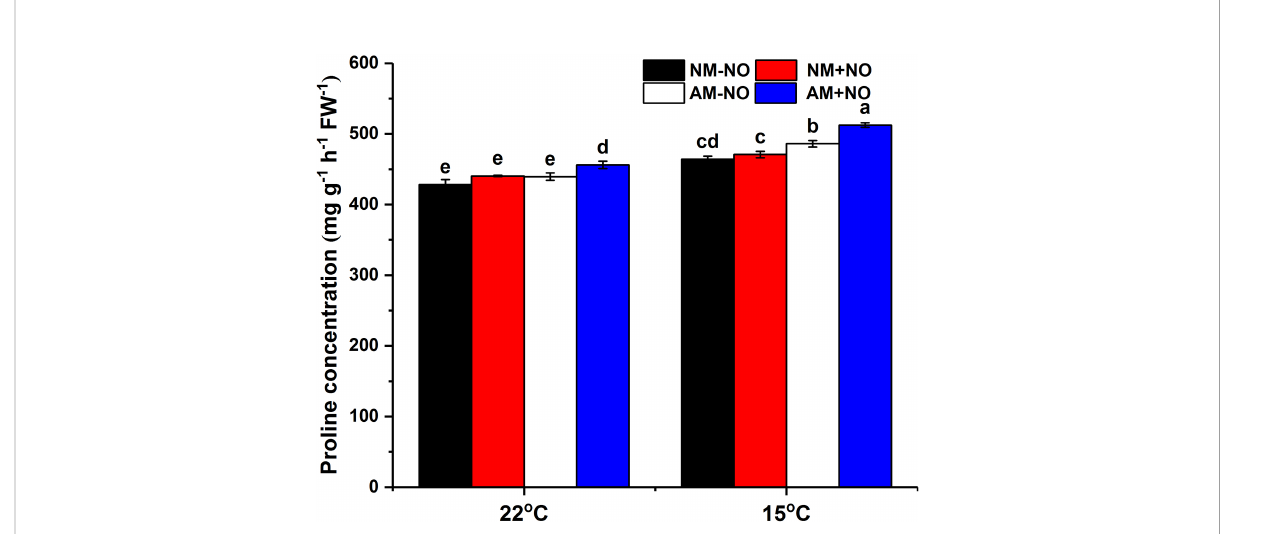
FIGURE 1 Proline concentration of non-mycorrhizal and mycorrhizal rice treated with different temperatures (25°C and 15°C) and exogenous NO. NM- NO: non-mycorrhizal rice without NO donor, SNP, treatment ( black bars ); NM+NO: NO donor treatment for non-mycorrhizal rice ( red bars ); AM-NO: mycorrhizal rice without NO donor treatment ( white bars ); AM+NO: NO donor treatment for mycorrhizal rice ( blue bars ), where the arbuscular mycorrhizal fungus was Rhizophagus irregularis. Values are the means ± standard errors of three biological replicates. Different letters in the column represent signi fi cant differences (P<0.05) based on Duncan ’ s test.